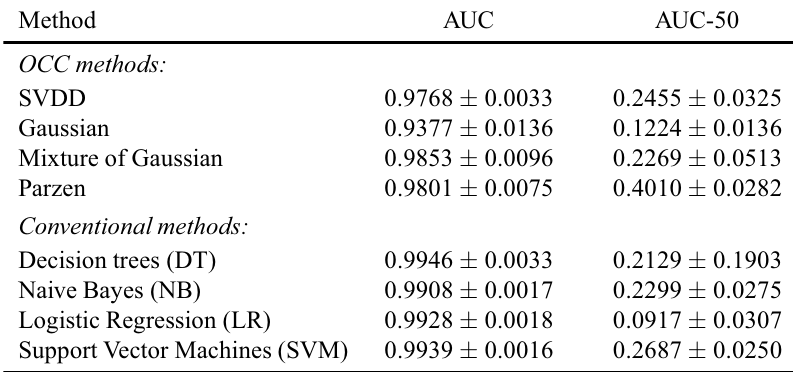
Table 1: Comparison of AUC and AUC-50 values for different learning methods evaluated